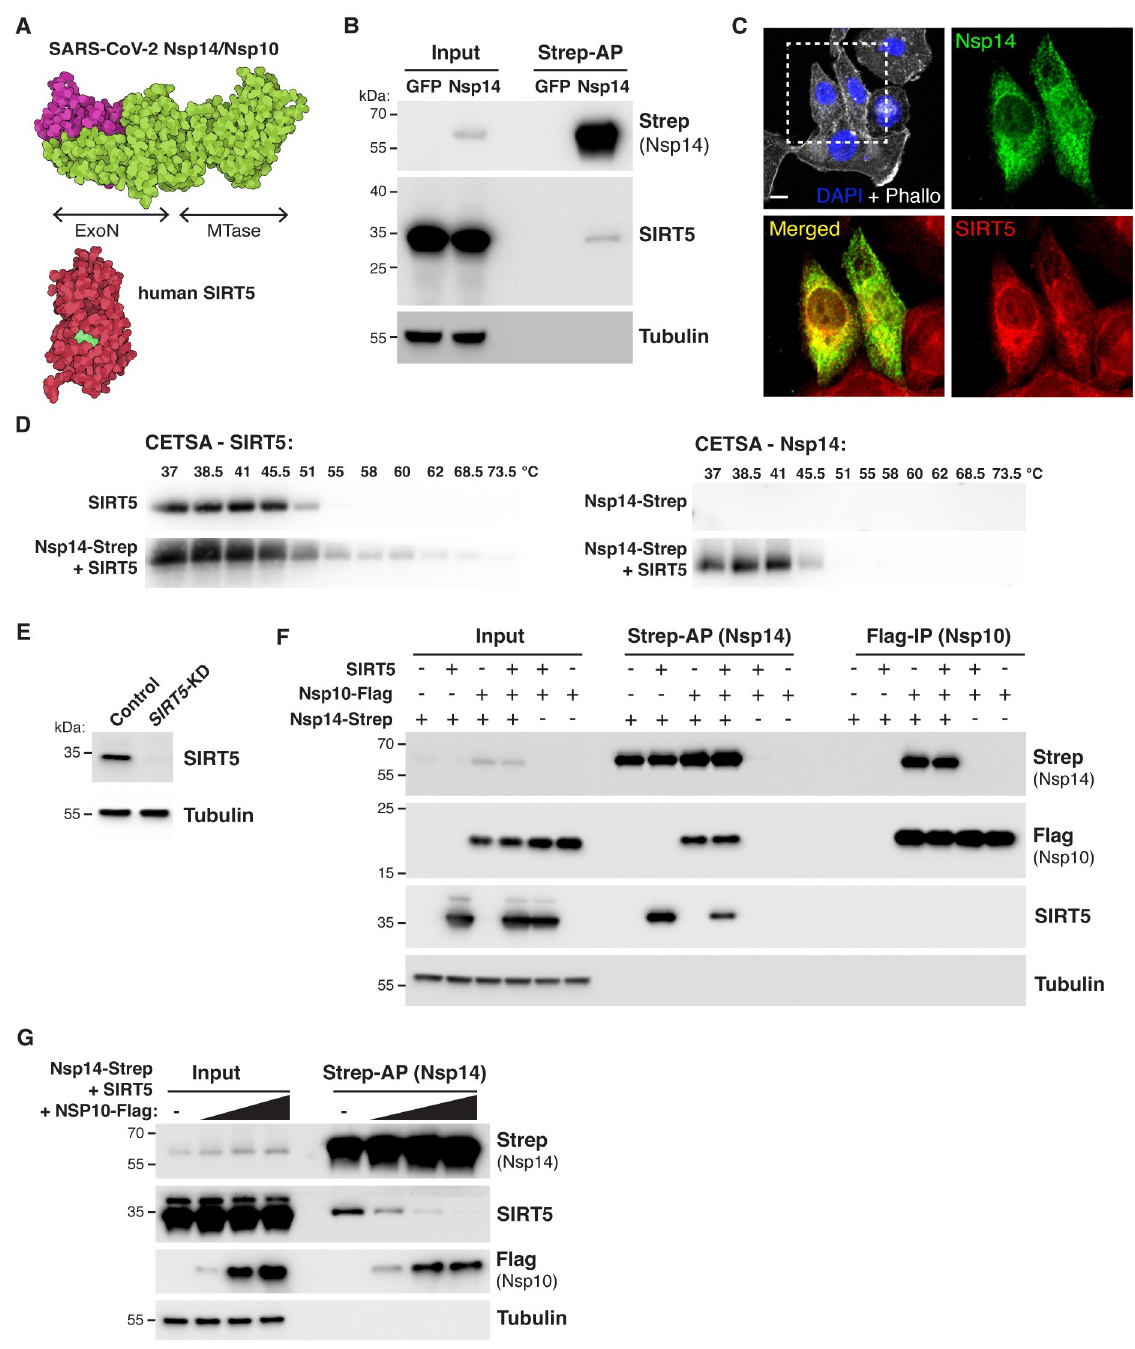
Fig 1. SARS-CoV-2 Nsp14 interacts with human SIRT5. A. Cartoon representation of the protein structure of Nsp14/Nsp10 (PDB 7N0B) and SIRT5 (PDB 3YIR) shows the Nsp14 N-terminal ExoN domain and C-terminal MTase domain. B. Affinity-purification of Nsp14-strep and co-purification of endogenous SIRT5 after transfection in HEK293T cells, as shown by western blot. C. Immunofluorescence of transfected Nsp14-Strep and endogenous SIRT5 in A549 cells. D. CETSA in HEK293T cells transfected with Nsp14-step and/or SIRT5, showing an increase in the stability of SIRT5 and Nsp14 by western blot. E. Western blot showing the absence of SIRT5 in SIRT5 -KD HEK293T cells. F. Strep-tag affinity-purification or Flag-tag immunoprecipitation, followed by western blot, after transfection with Nsp14-strep, Nsp10-flag and SIRT5 expression constructs. SIRT5 does not interact with Nsp10. 0.5 μ g of each construct or of empty control plasmids were transfected in SIRT5 -KD HEK293T cells in a six-well plate. G. Strep-tag affinity-purification and western blot after transfection of Nsp14-strep, SIRT5 and increasing concentrations of Nsp10-tag indicate competitive binding of SIRT5 and Nsp10. 0.5 μ g of Nsp14-strep and SIRT5 plasmid were used in a 6-well plate, with 0, 0.5, 1 or 2 μ g of Nsp10-Flag.